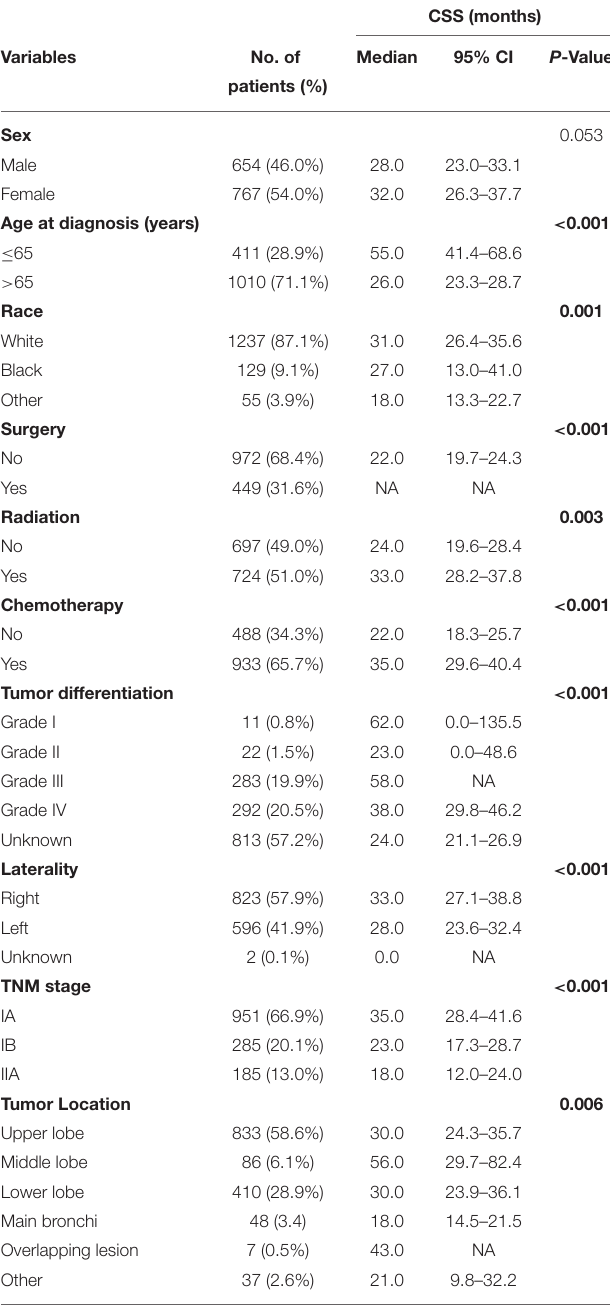
TABLE 1 | The characteristics and the results of K–M analysis in limited SCLC